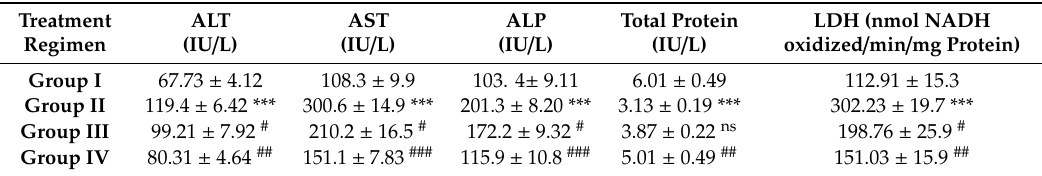
Group-I: normal control; Group-II: doxorubicin (20 mg / kg bw); Group-III: Dox rats treated with naringenin (50 mg / kg bw / day); and Group-IV: Dox rats treated with naringenin (100 mg / kg bw / day). Data are represented as mean of six rats ± naringenin (50 mg/kg bw/day); and Group-IV: Dox rats treated with naringenin (100 mg/kg bw/day). Data are represented as mean of six rats ± S.E.M.